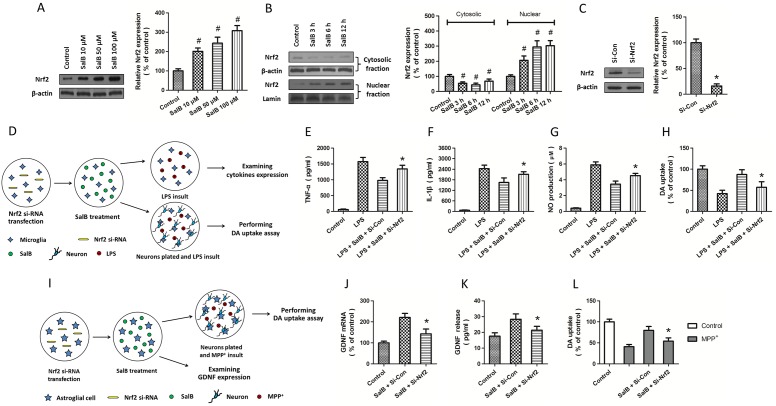
Role of Nrf2 in SalB-induced neuroprotection.Mouse midbrain neuron-glia cultures were treated with various concentrations of SalB (10, 50 or 100 µM) for 24 h, and the expression of Nrf2 was examined by western blot (A). Mouse midbrain neuron-glia cultures were treated with SalB (100 µM), and the expression of Nrf2 in cytosolic fraction and nuclear fraction were examined by western blot at 3, 6 or 12 h after SalB treatment (B). Mouse midbrain neuron-glia cultures were transfected with Nrf2-specific siRNA (Si-Nrf2) or control siRNA (Si-Con) for 72 h, and the expression of Nrf2 was examined by western blot (C). D: Schematic illustration of the experimental protocol (E–H). Microglia-enriched cultures were transfected with Nrf2-specific siRNA (Si-Nrf2) or control siRNA (Si-Con) 72 h prior to SalB (100 µM) treatment and LPS injury (20 ng/ml for 4 d) with (H) or without (E, F and G) neurons plantation. TNF-α (E), IL-1β (F), NO production (G) and DA uptake (H) were assayed. I: Schematic illustration of the experimental protocol (J–L). Astroglia-enriched cultures were transfected with Nrf2-specific siRNA (Si-Nrf2) or control siRNA (Si-Con) 72 h prior to SalB (100 µM) treatment with (L) or without (J and K) neurons plantation and MPP+ injury (200 µM for 48 h). The expression of GDNF mRNA (J), GDNF release (K) and DA uptake (L) were measured. Data are either representative of three similar experiments or are shown as mean ± SD of five experiments. #
p<0.05 vs. Control. *p<0.05 vs. control siRNA.